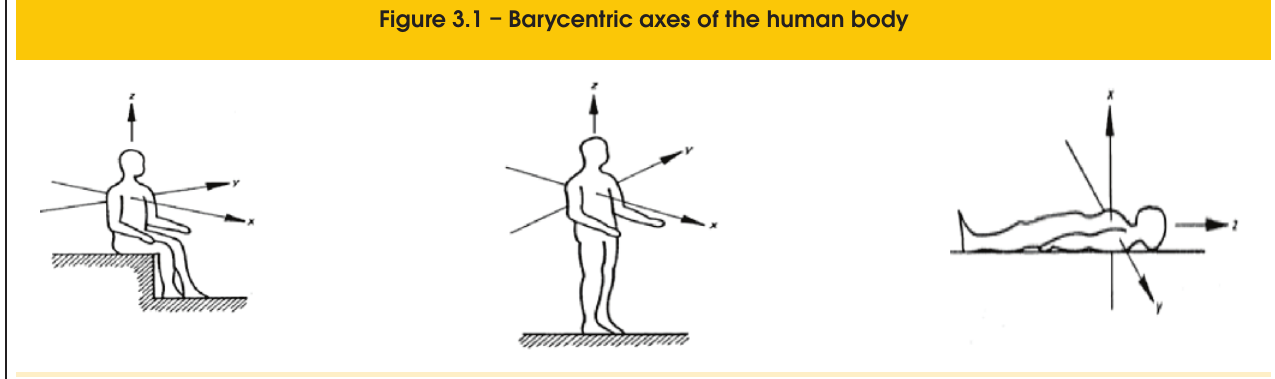
Figure 3.1 – Barycentric axes of the human body